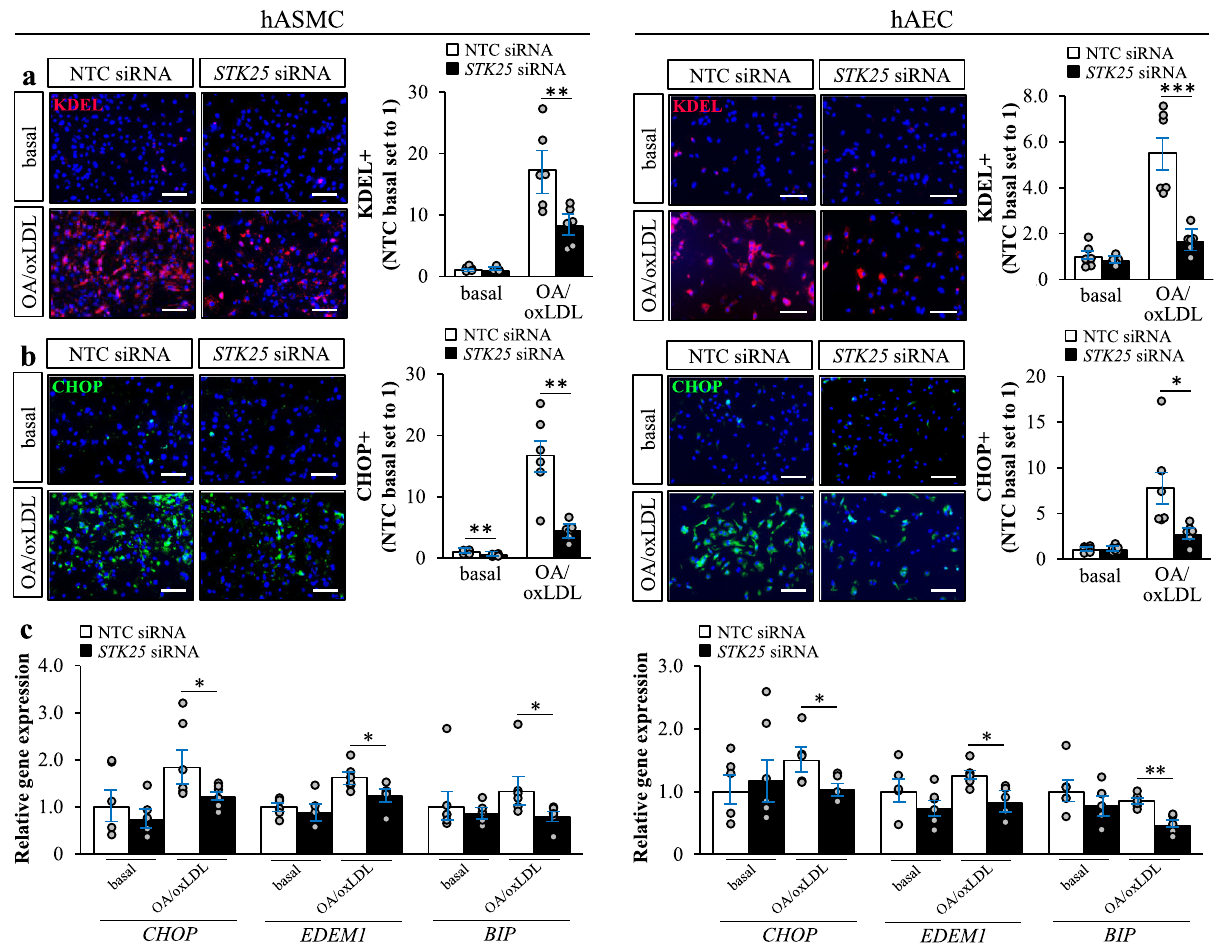
Fig. 4 STK25 controls ER stress in human aortic endothelial and smooth muscle cells. hASMCs and hAECs were transfected with STK25 siRNA or NTC siRNA. a , b Representative images of cells processed for immuno fl uorescence with anti-KDEL (red) or anti-CHOP (green) antibodies; nuclei stained with DAPI (blue). Quanti fi cation of the staining. c Relative gene expression of selected ER stress markers. In ( a , b ), the scale bars represent 100. Data are mean ± SEM from 5 to 6 wells per group. OA, oleic acid. * P < 0.05, ** P < 0.01, *** P < 0.001 for STK25 siRNA vs . NTC